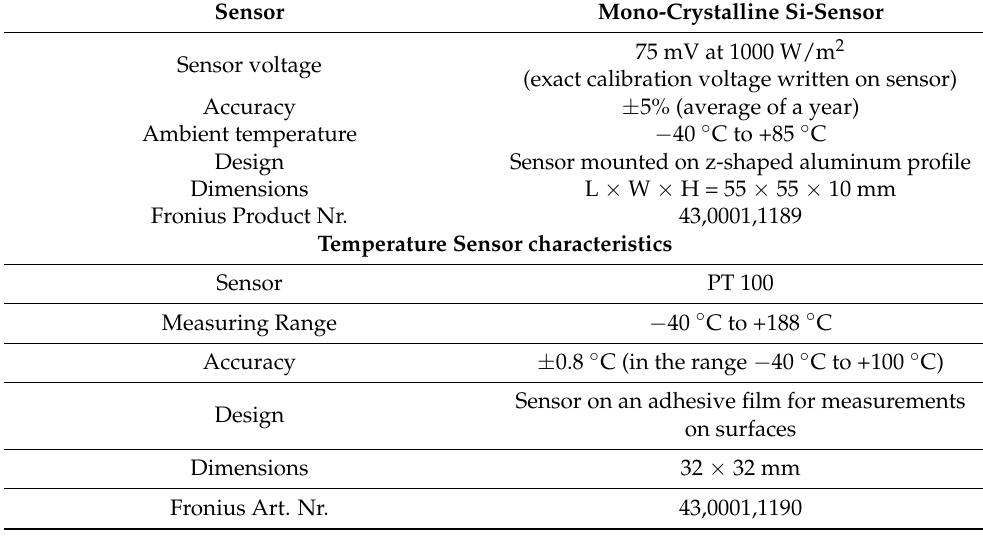
Figure A2. General layout of PV systems. Table A3. Irradiance sensor characteristics.